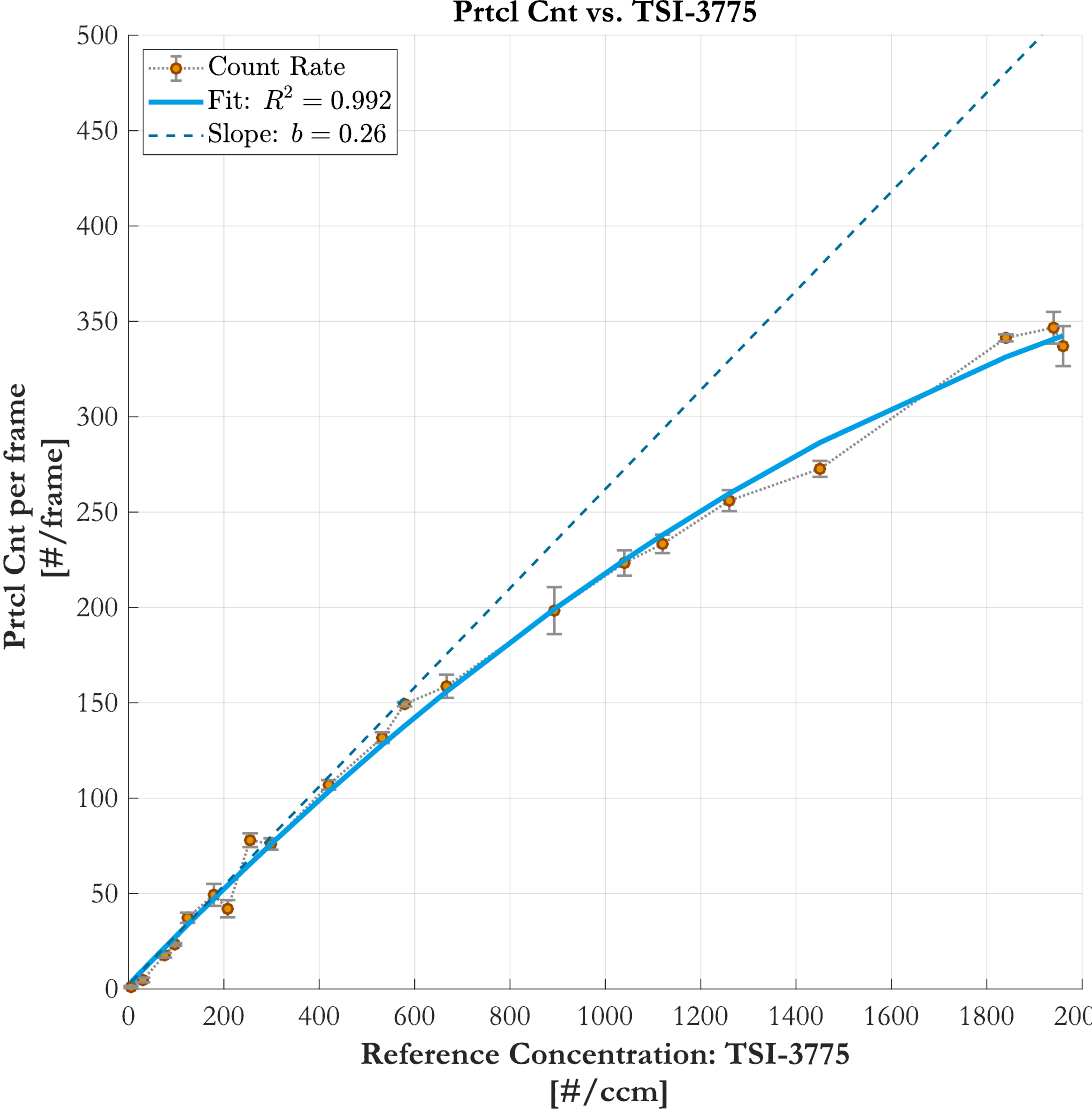
Figure 7. Comparison of the counting rate of the Particle Imaging Unit (PIU) to the monitored particle number concentration. The slobe b of the fit can be interpreted as the correlation